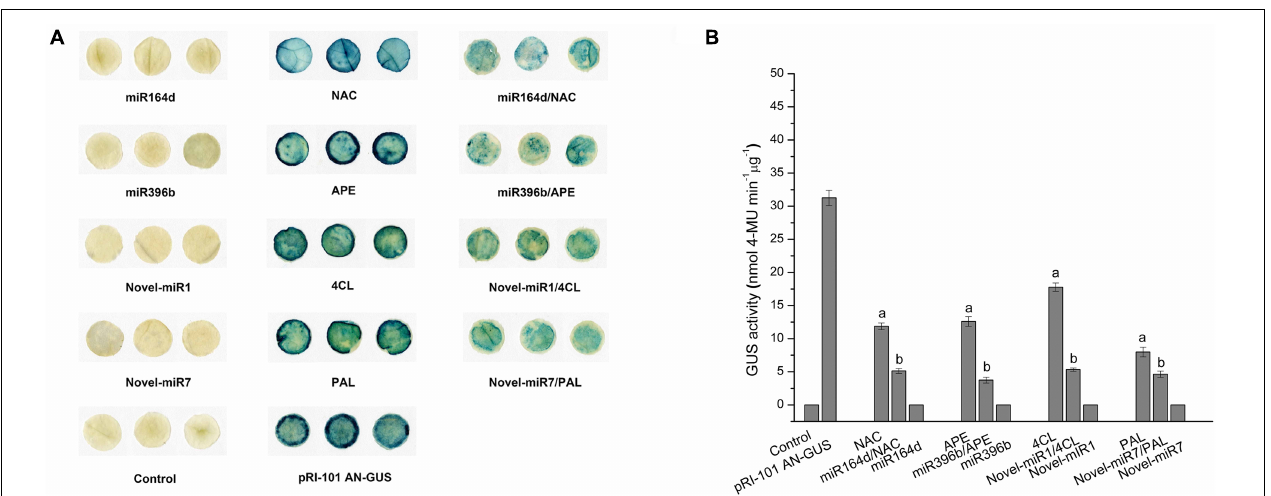
FIGURE 2 | GUS assay of transiently transformed tobacco leaves. (A) GUS accumulation by histochemical staining. (B) GUS fluorescence quantitative assay. Significance was determined by Duncan’s multiple range test ( P <